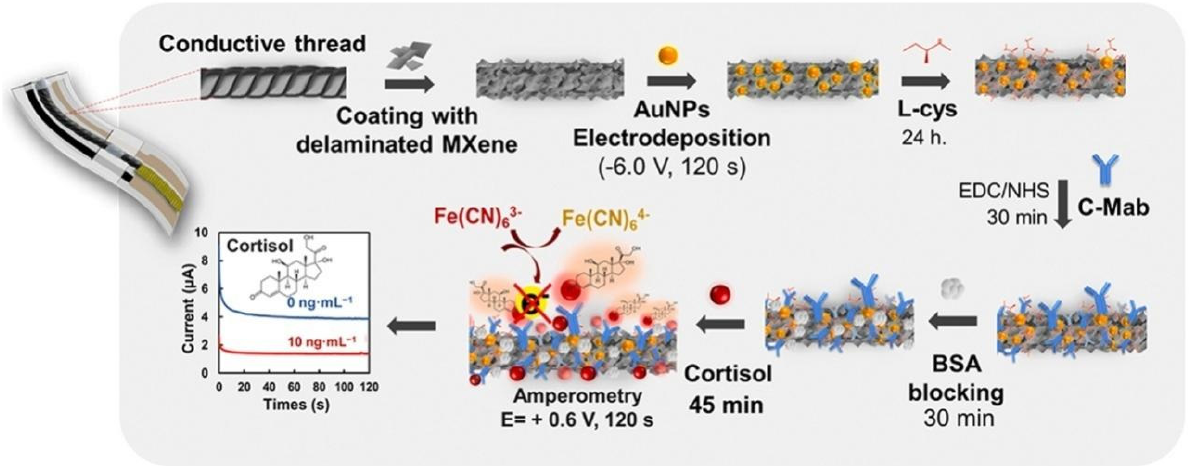
Figure 4. Schematic illustration of the fabrication steps of the thread-based electrochemical im- munosensor for cortisol detection. Reprinted with permission from Ref. [56]. 2022, Elsevier.